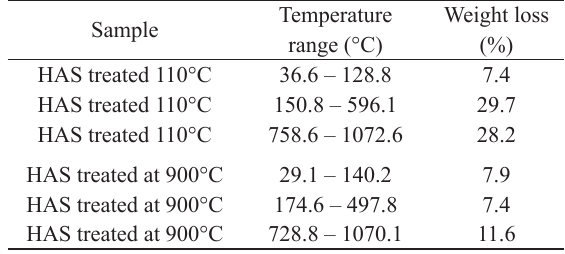
Temperature range and corresponding % weight loss for the samples HAS treated at 110 and 900°C after contact with SBF for three days.